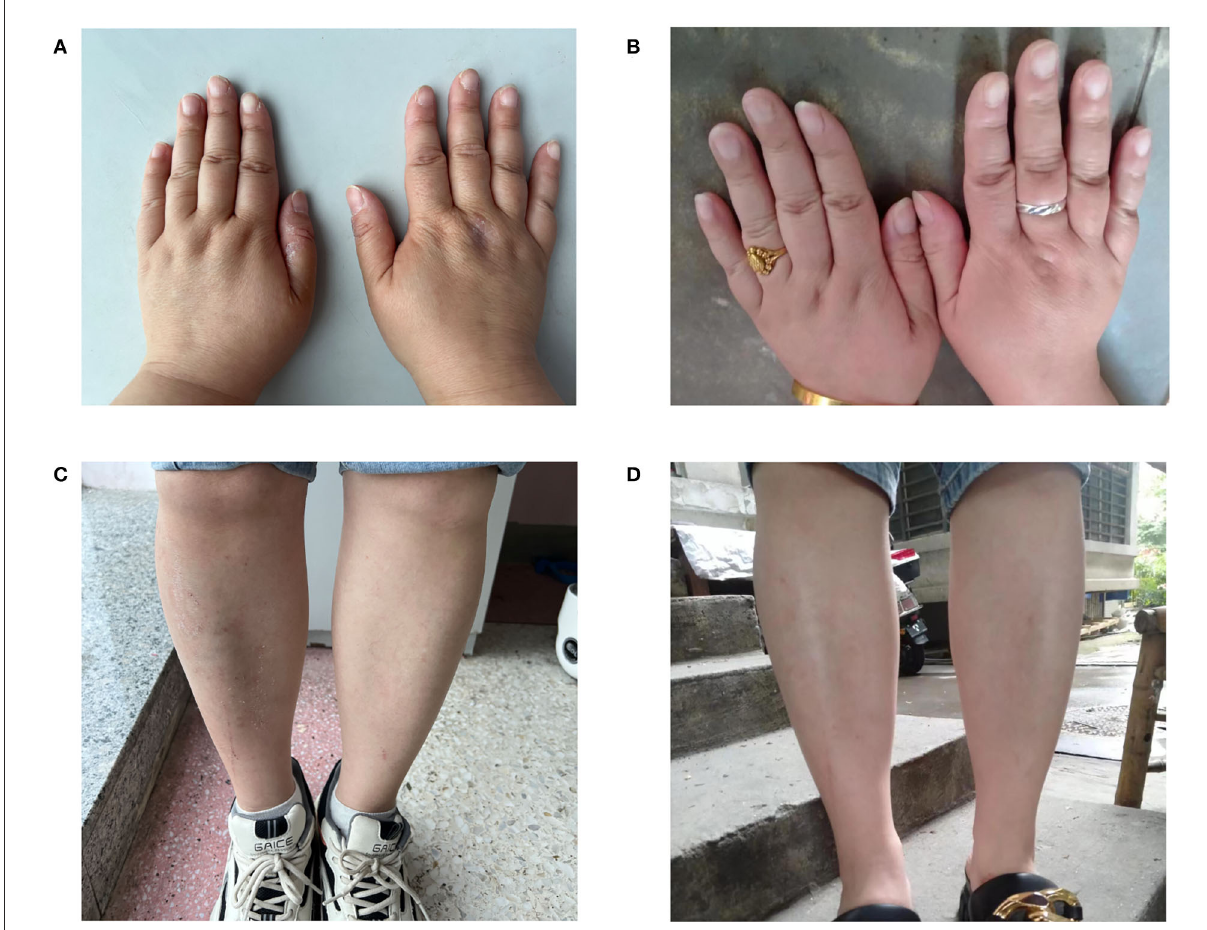
FIGURE1 Limbs edema relived after antidepressant therapy at 7 days (A,C) and 3 weeks (B,D)